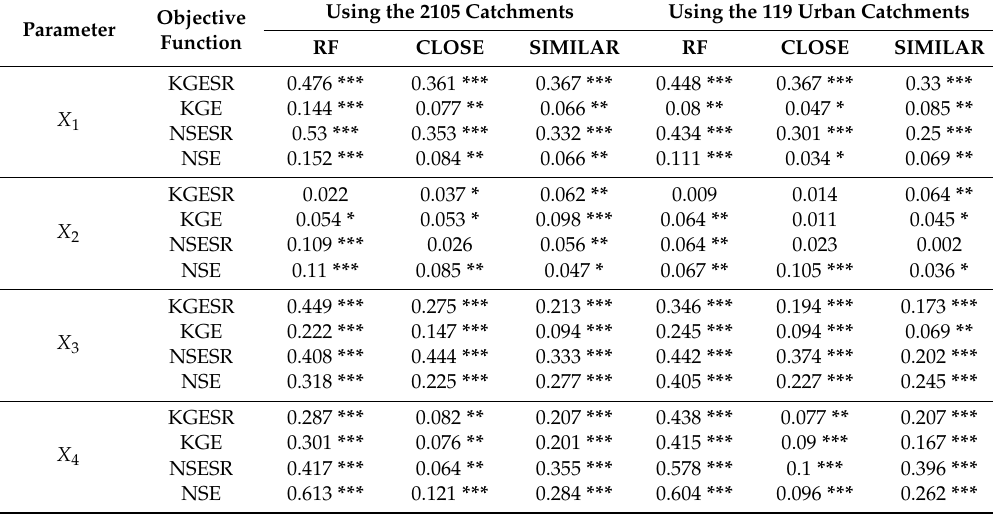
Table 2. R 2 computed between the calibrated parameters with respect to di ff erent objective functions (KGESR, KGE, NSESR, and NSE) and the estimated parameters via RF, transferred parameters from the close and from the similar catchments for the 120-urban-catchments sample. Statistical significance of the correlation is indicated by asterisks, where * is significant at 5%, ** at 1%, and *** at 0.1% risk. Using the 2105 Catchments Using the 119 Urban Catchments Objective Parameter Function RF CLOSE SIMILAR RF CLOSE